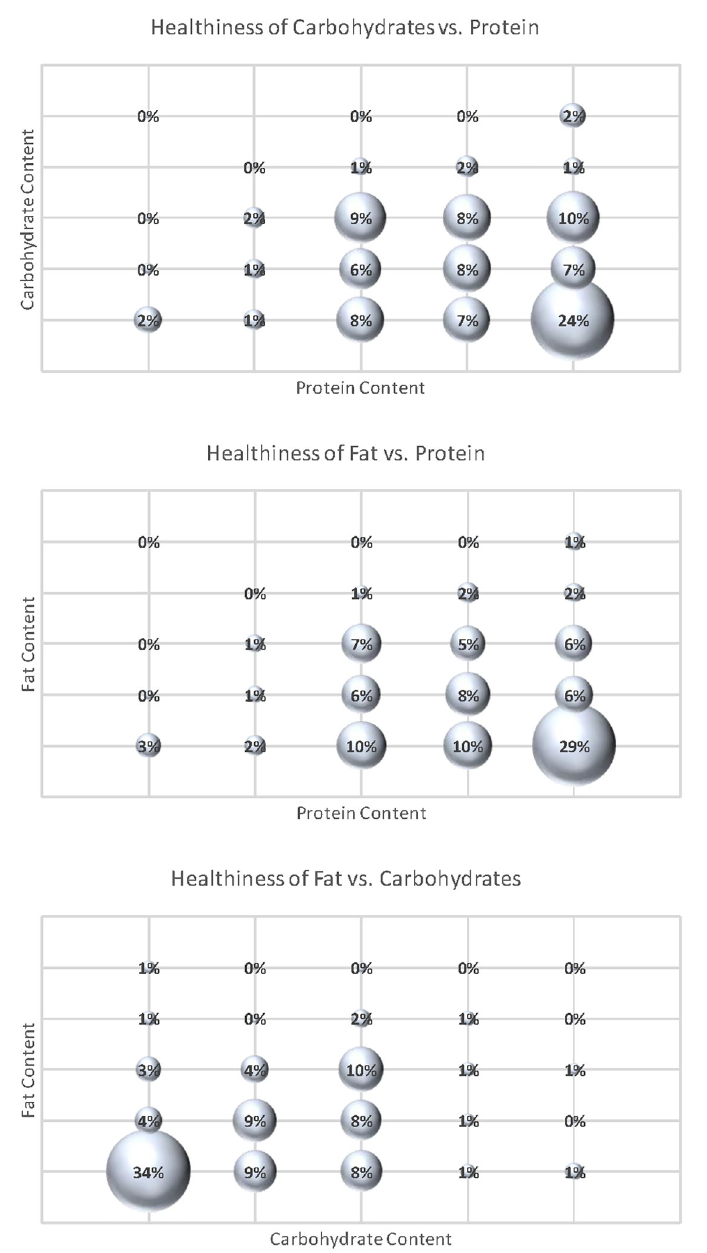
Fig 5. Joint perceptions of healthiness of carbohydrates, fat, and protein ( sampling error for each statistic is ±2 . 7% . )